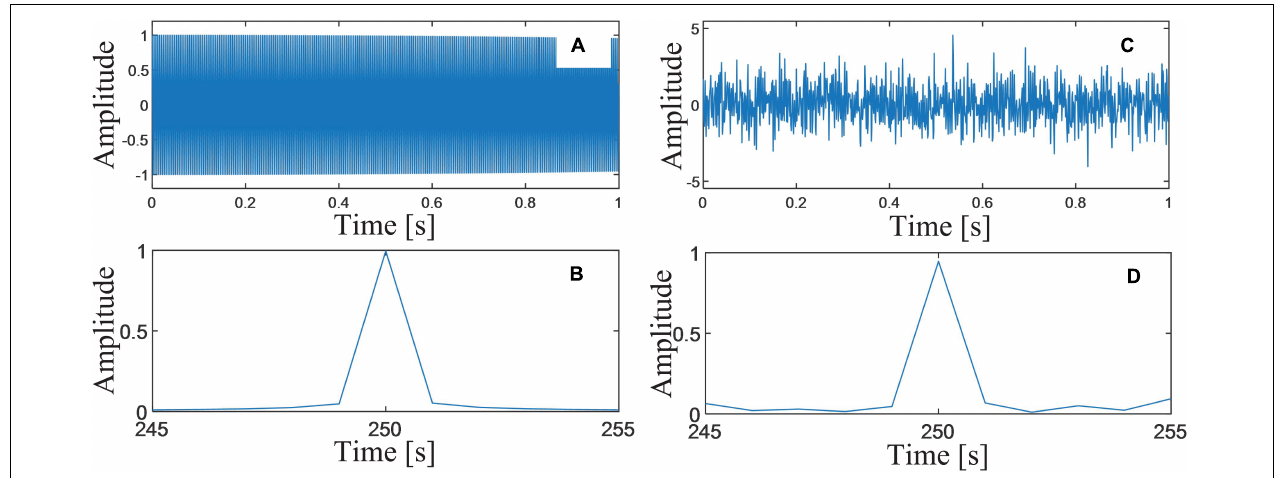
FIGURE 3 | (A) Waveform of the simulated PLA; (B) FFT spectrum of the simulated PLA; (C) the simulated PLA with noises (SNR = 0dB); and (D) FFT spectrum of the simulated PLA with noises.